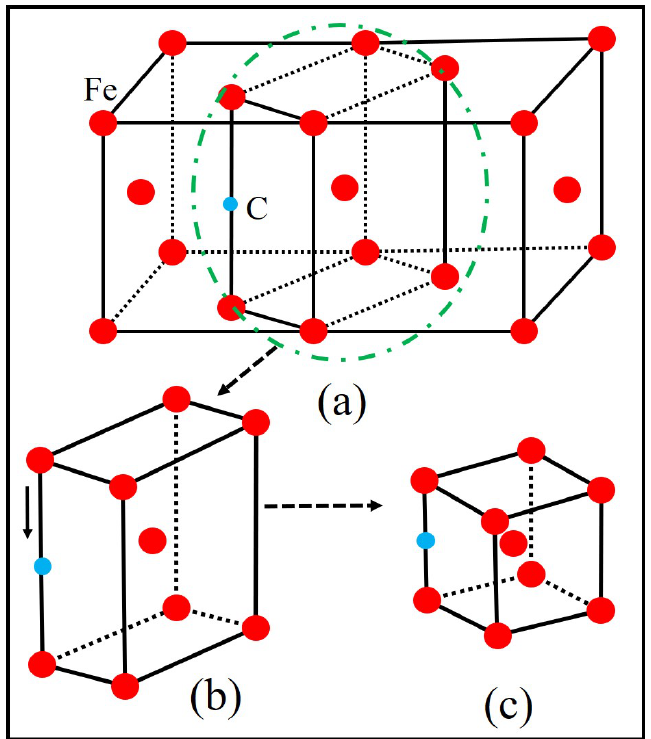
Figure 3. The figure shows the transformation of austenite to martensite in different stages (The Bain strain). Picture ( a ) showing an austenite lattice in which martensite formation begins (dotted green circle) with a carbon atom in octahedral place. ( b ) Body Centric Tetragonal (BCT) unit cell that is formed inside an austenite, and the final transformation ( c ) after lattice deformation forming a proper martensite via compression along the vertical axis [27]. Adapted with permission from [27].